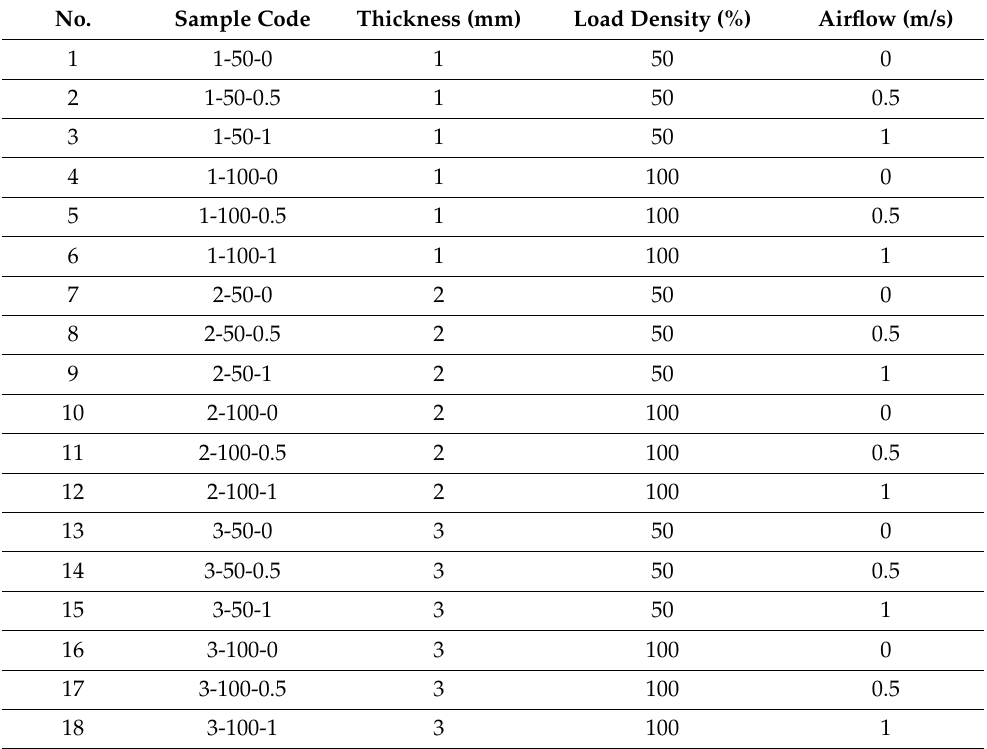
Table 1. Experimental design with three independent